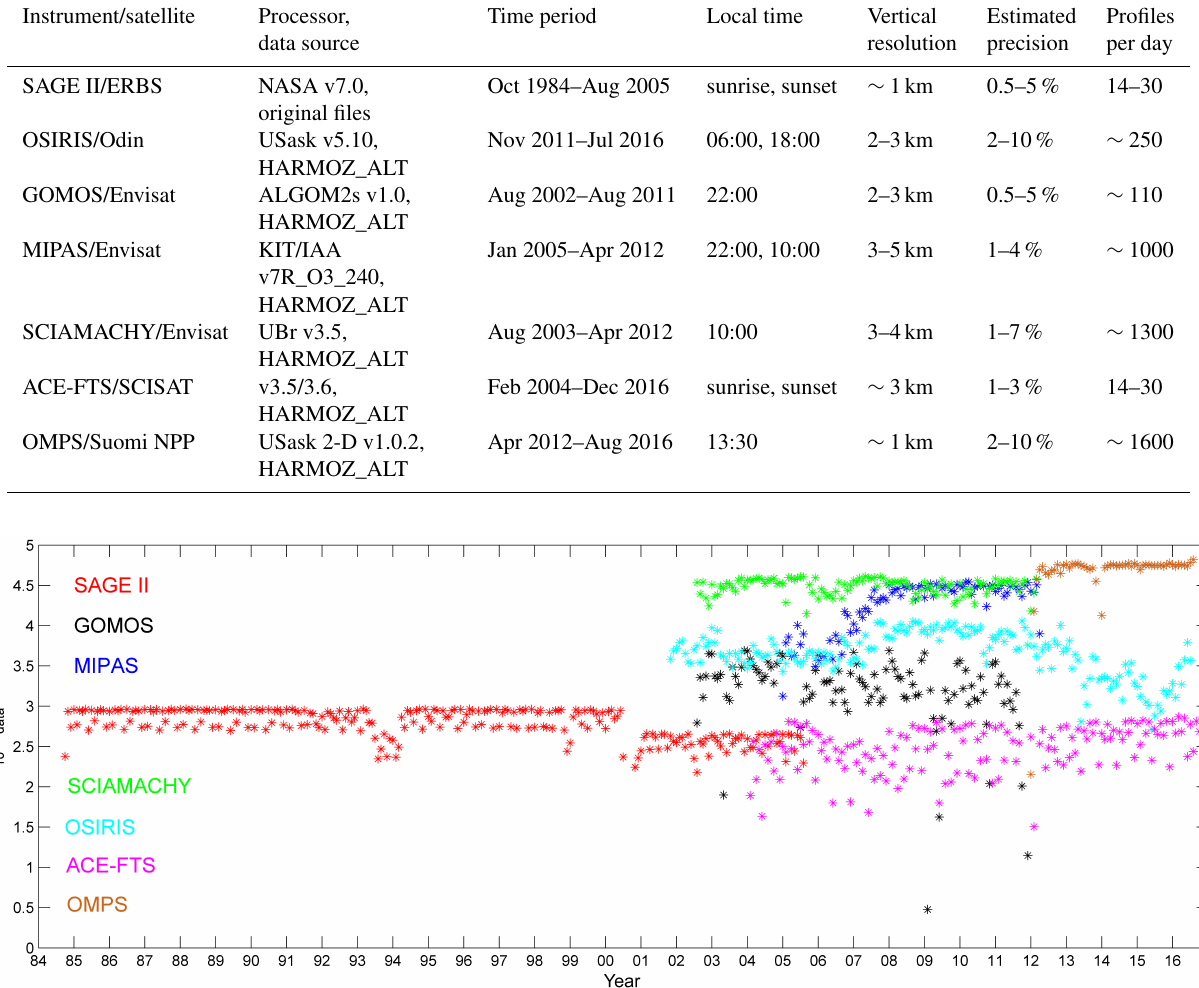
Table 1. Information about the datasets used in the merged dataset.